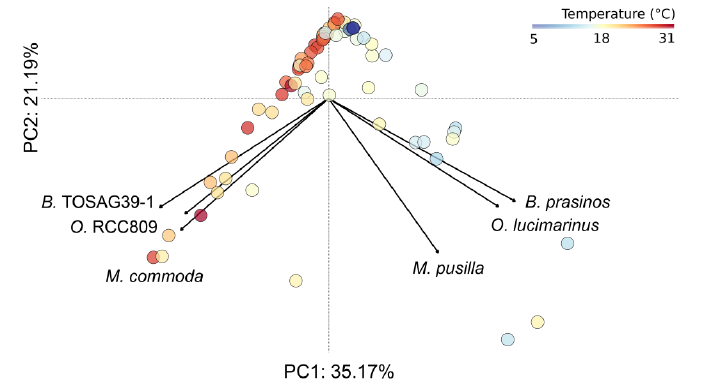
Figure 2. Principal component analysis computed on relative metagenomic abundances of the six Mamiellales. Each circle corresponds to a sample and is colored according to water